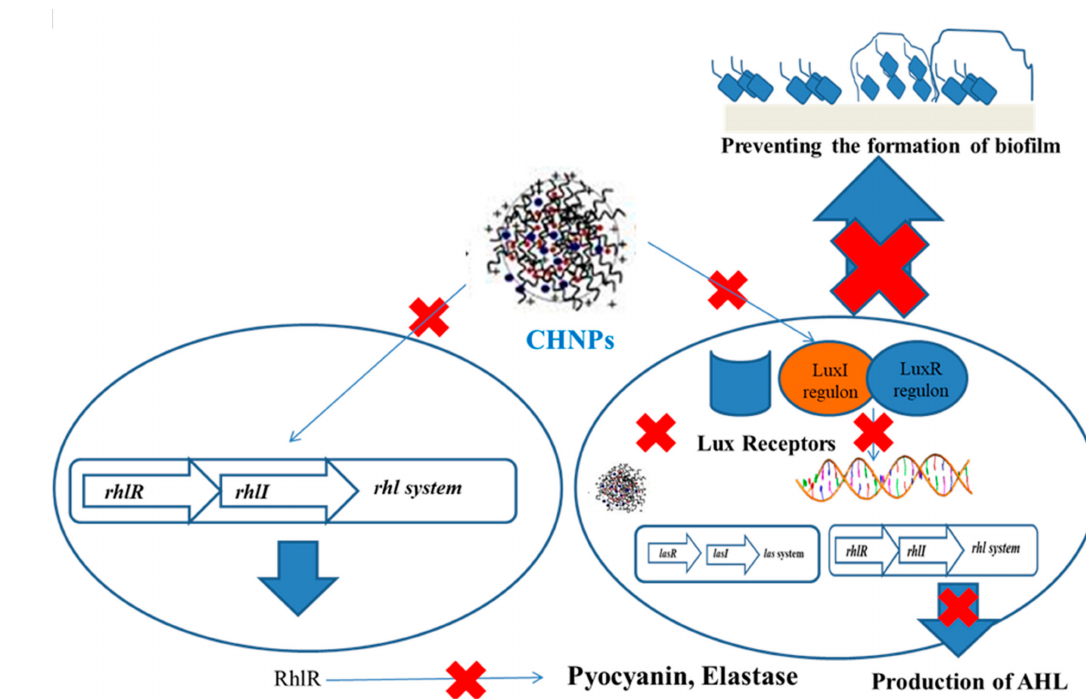
Figure 2. Mechanism of inhibition of biofilm by